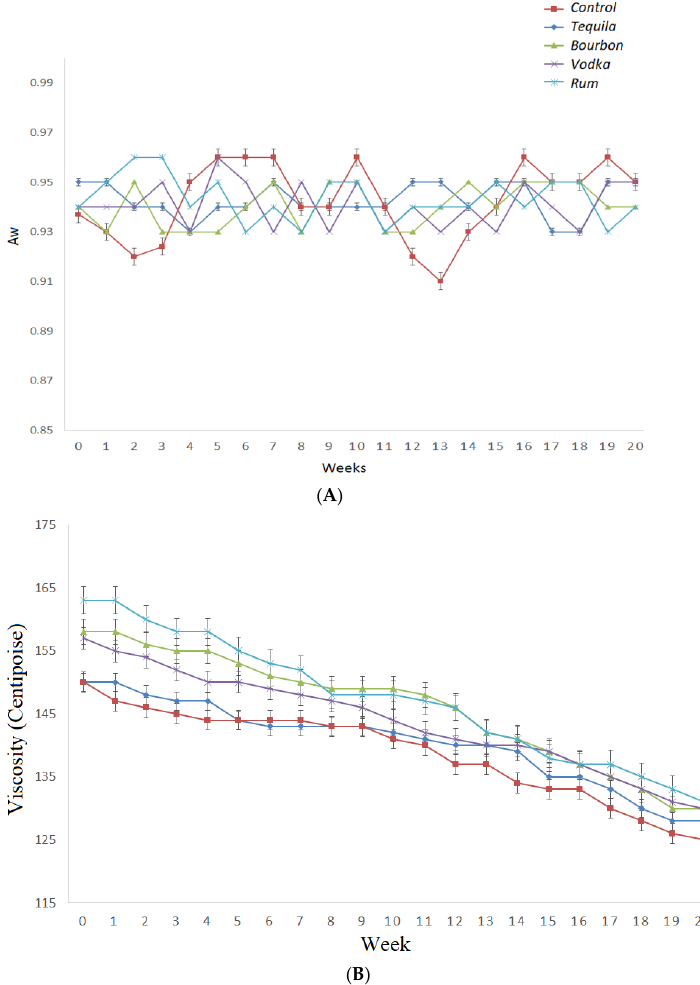
Figure 3. Water activity ( A ) and viscosity ( B ) of hot sauces prepared with tequila (dark blue line), bourbon (green line), vodka (purple line), rum (light blue line), and control (brown line) during 20 weeks of storage under accelerated conditions.